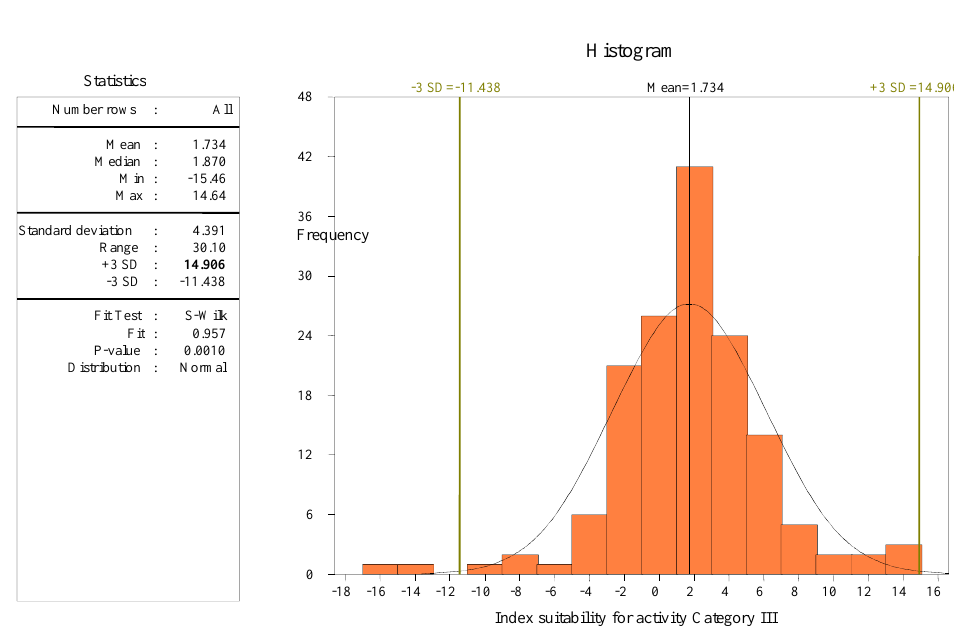
Figure 1 – The histogram of the estimation error for Category III activities (Estimation error ε =